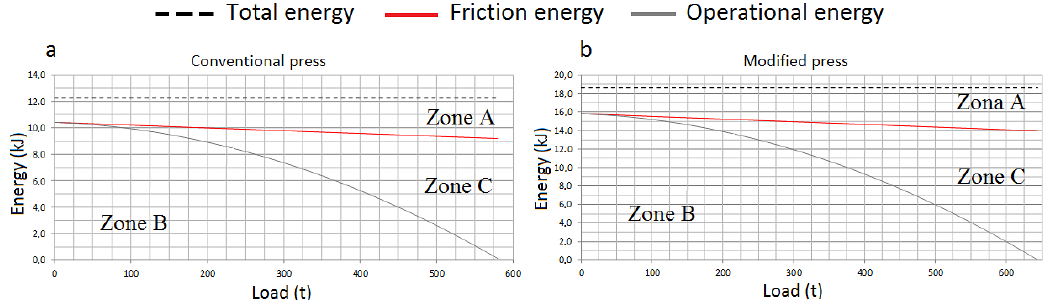
Figure 8. Operating conditions to deform the specimens at the conventional ( a ) and the modified ( b )